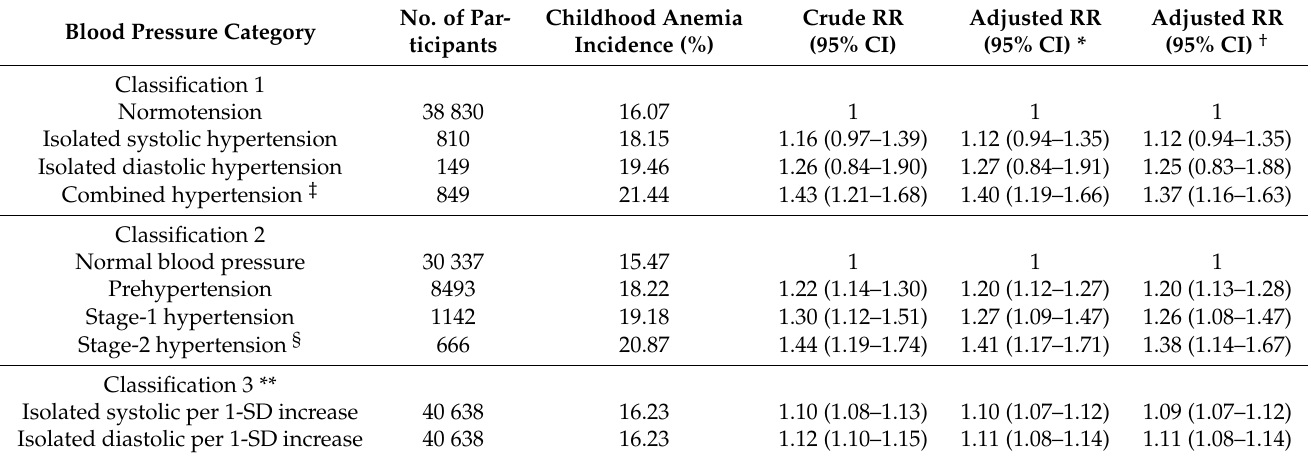
Table 3. Childhood anemia incidence and risk according to maternal blood pressure category in